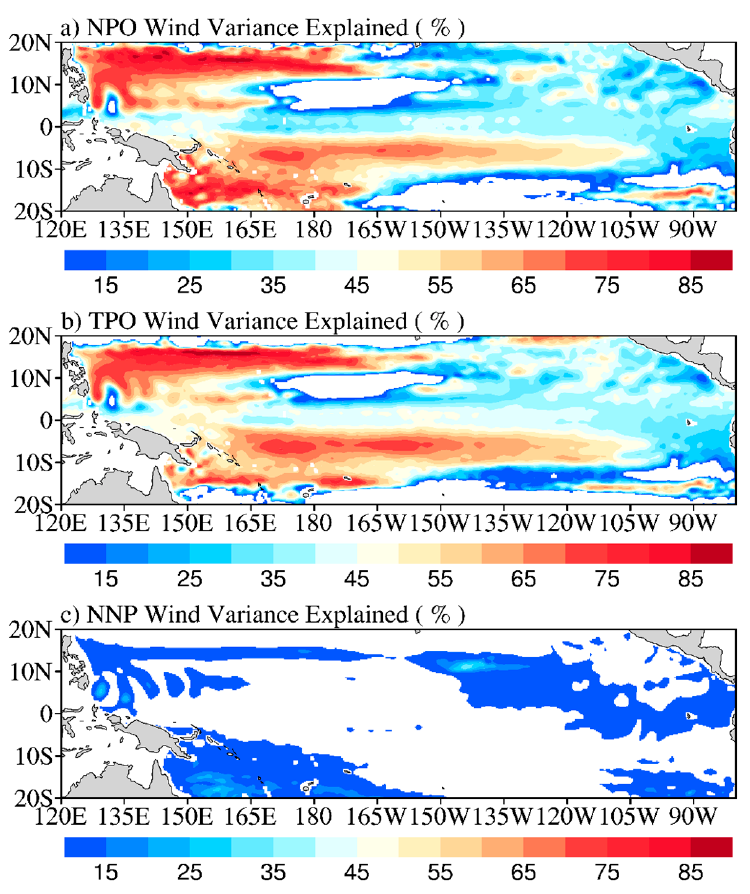
Figure 10. Contributions of different wind forcing to decadal sea level variations: ( a ) the real monthly wind field; ( b ) the real wind field in the TPO and the climatic wind field in other regions; ( c ) the real wind field in other regions and the climatic wind field in the TPO. The eastern and western TPO has recently exhibited a seesaw spatial pattern of annual mean sea level anomalies (Figure 11a). Sea level anomalies and negative sea level anomalies alternately appeared during 1993–1995, especially when ENSO occurred. Negative anomalies (blue) occurred during El Niño: 1997, 1997, 2002–2005, 2007,